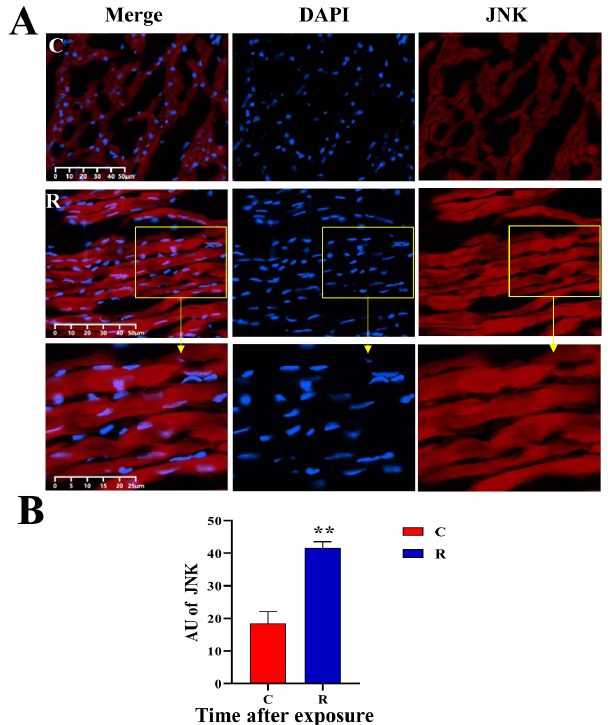
Figure 14. Changes in JNK expression and distribution of rats’ myocardium after S-band radiation. ( A ) Original graph of IF; ( B ) statistical analysis graph of average fluorescence intensity (AU). Signifi- cance signs were classified according to p -value: ** p < 0.01. The yellow box is the magnified area.